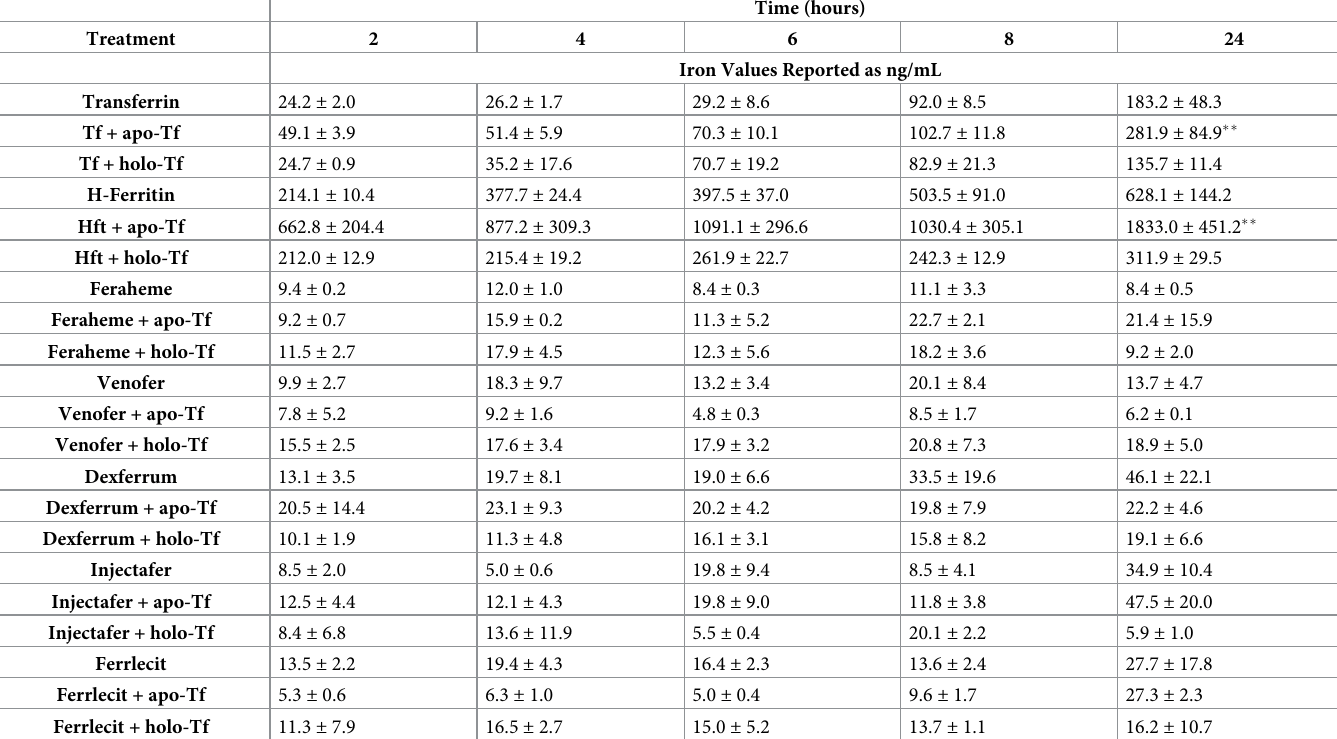
Table 1. Transport of iron across the BBB.